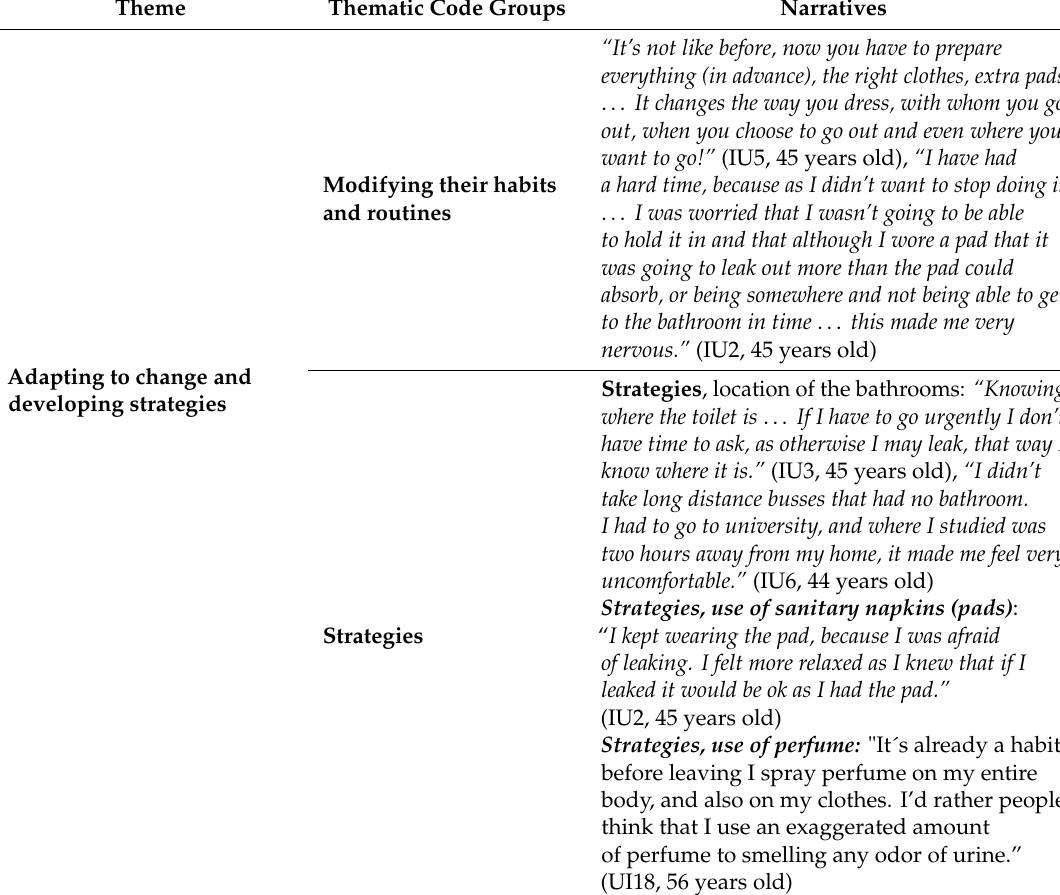
Table 5. Participants’ narratives from the theme: Adapting to change and developing